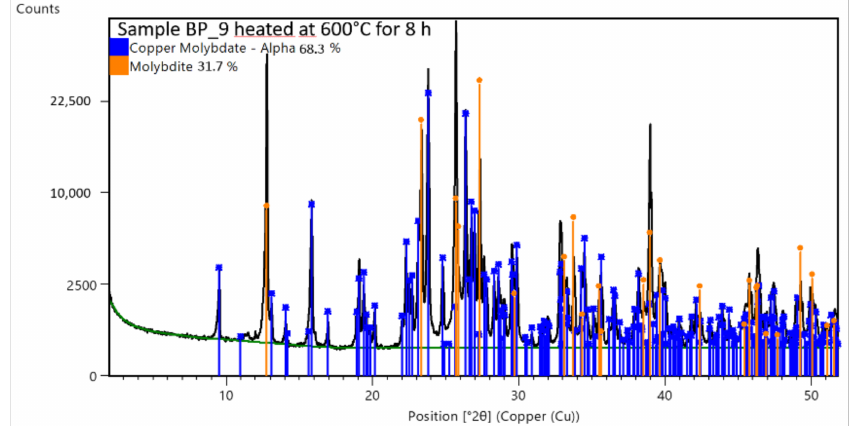
Figure 6. XRD of sample BP_9 after heating at 600 ◦ C for an entire night (about 8 h).